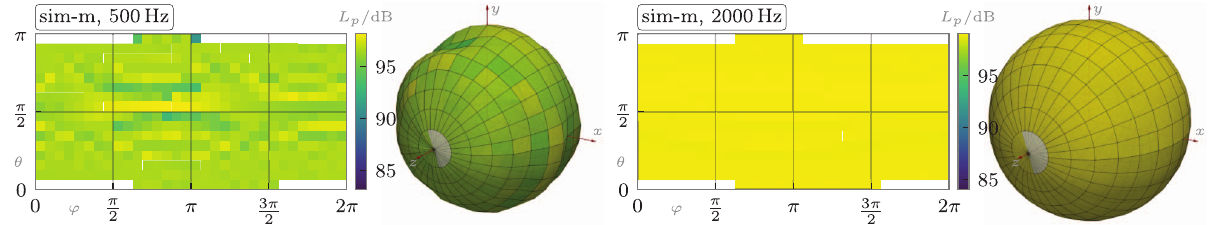
Figure 10. Simulated monopole: visualization of the directional sound radiation using the EA 512 grid, evaluated for two octave bands.